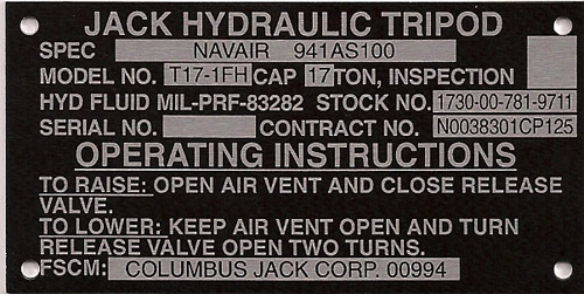
Fig. 6 Example of nameplate recognition